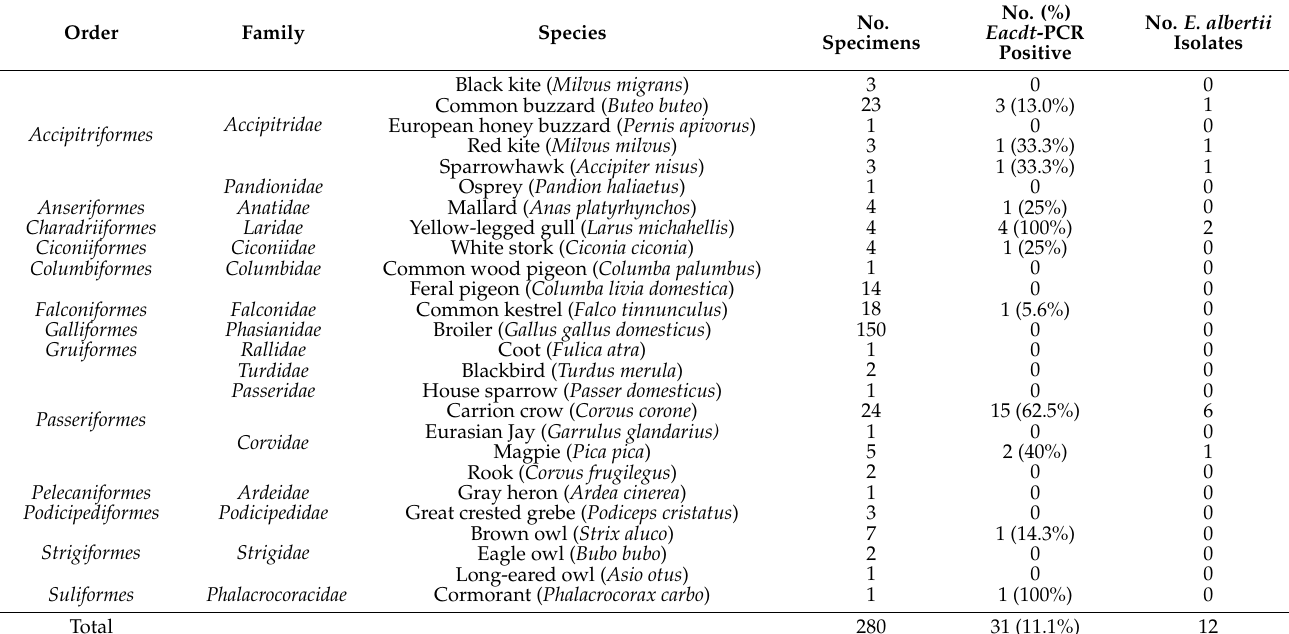
Table 1. List of sampled birds; number of Eacdt -positive samples and number of recovered E. albertii